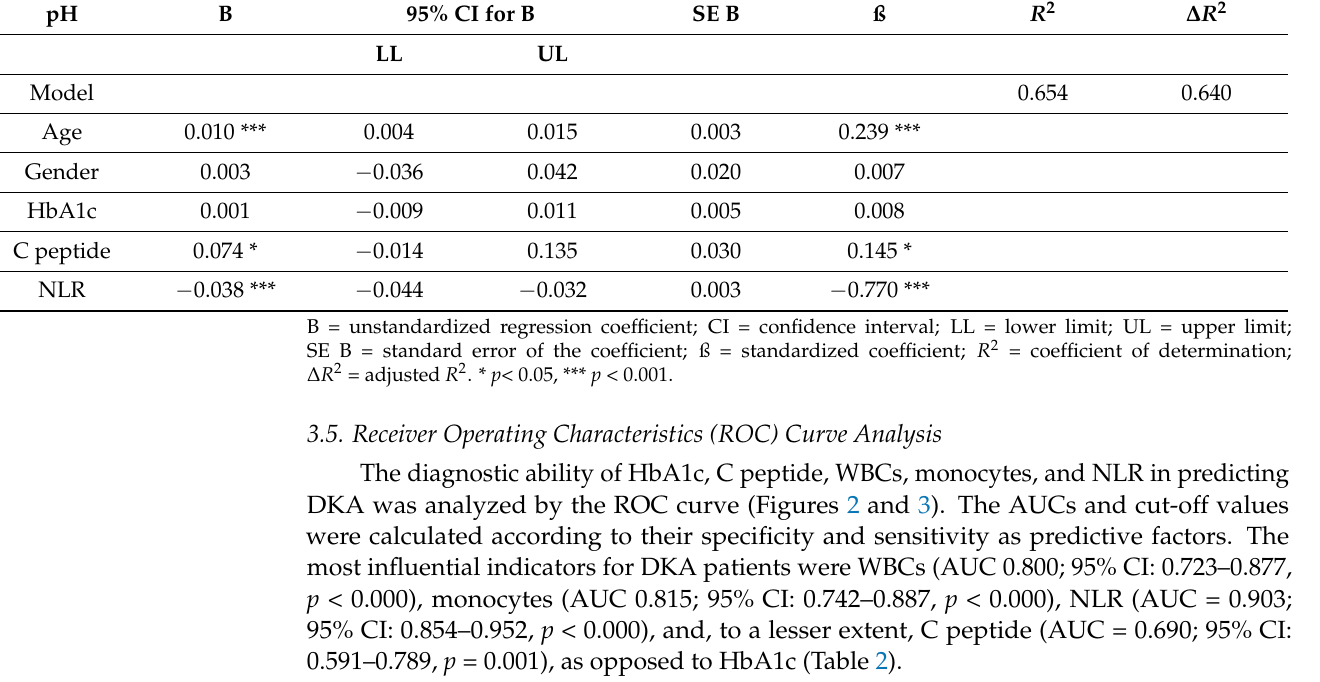
Table 2. Linear regression analysis of factors related to blood pH in new-onset T1DM patients.